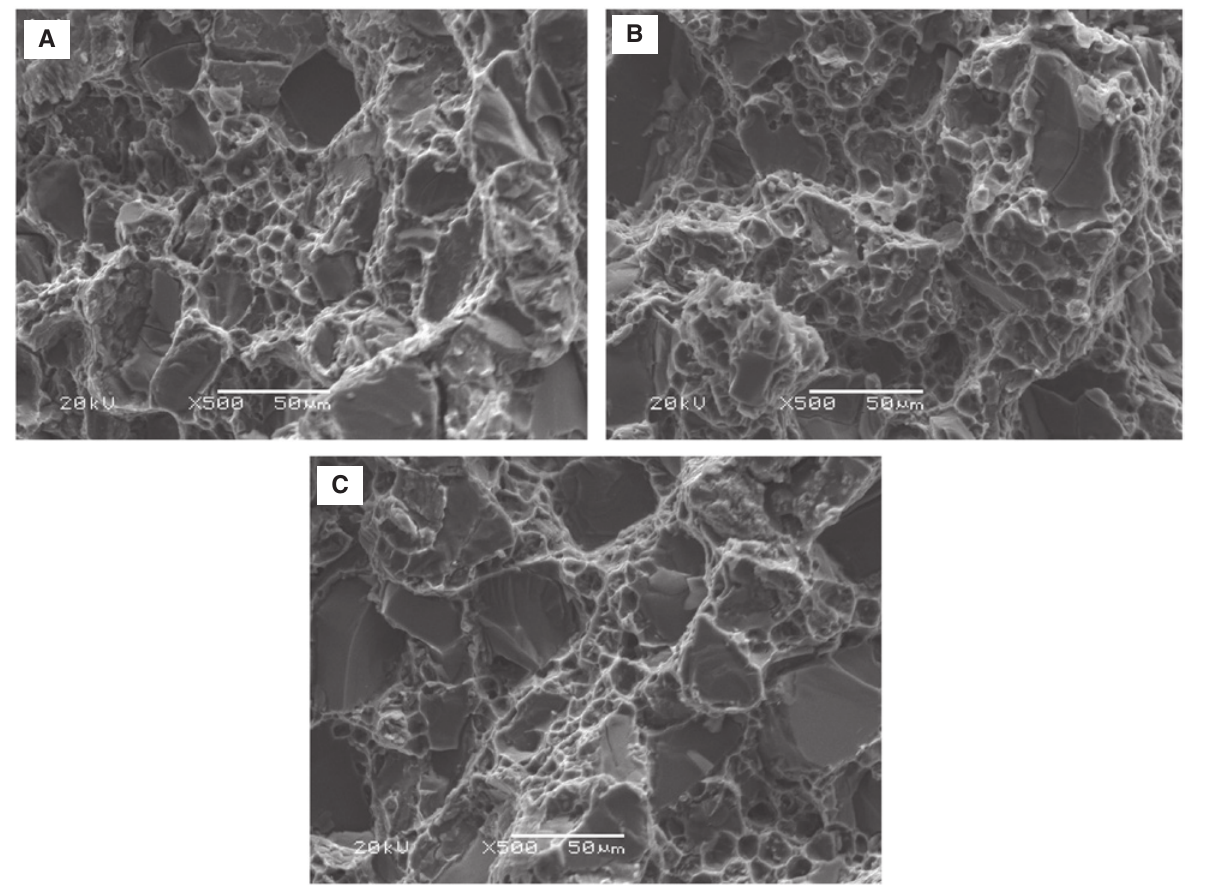
Figure 6 The Secondary electron SEM micrographs of fracture surfaces of the composite hot pressed at (A) 520 ° C, (B) 580 ° C and (C) 600 °